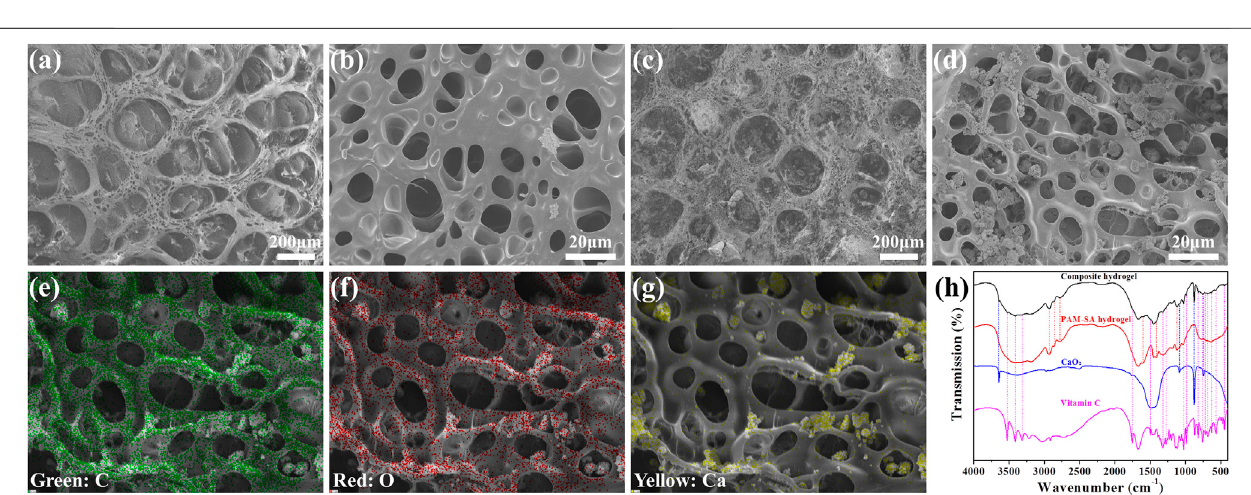
FIGURE 2 | (A) SEM image of PAM-SA hydrogel at low magni fi cation. (B) SEM image of PAM-SA hydrogel at a high magni fi cation. (C) SEM images of the composite hydrogel at a low magni fi cation. (D) SEM images of the composite hydrogel at a high magni fi cation. (E) Element distribution mapping image of carbon under SEM. (F) ElementdistributionmappingimageofoxygenunderSEM. (G) ElementdistributionmappingimageofcalciumunderSEM. (H) FTIRspectraofvitaminC,CaO 2 , the PAM-SA hydrogel, and the composite hydrogel.